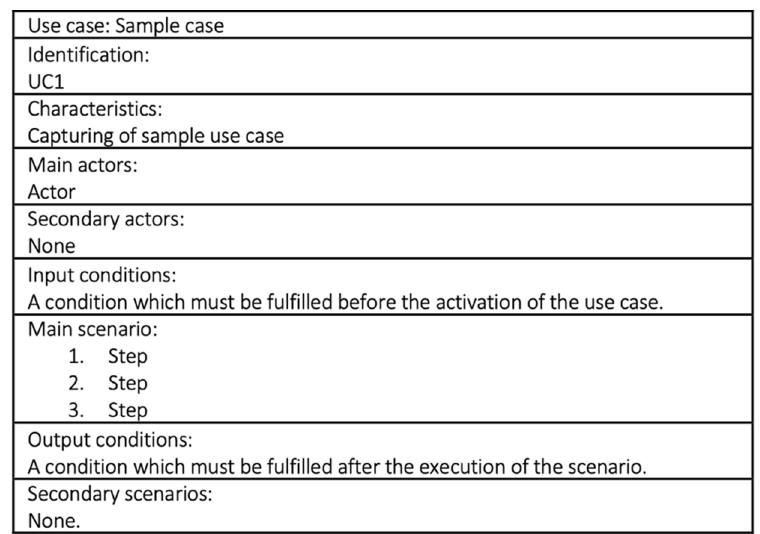
Figure 2. General structure of a use case scenario.